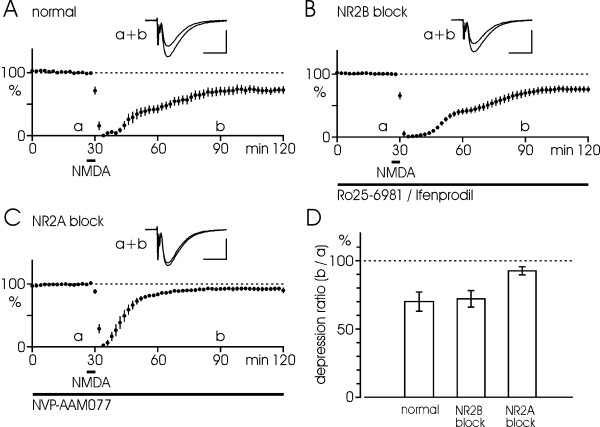
Roles of NR2B and NR2A subunits in NMDA-induced LTD. (A) NMDA application (30 μM, 4 min) under normal conditions causes initial extinction of EPSPs, followed by recovery and stabilization (n = 15). (B) NR2B inhibitors, Ro25-6981 (0.5 μM) or Ifenprodil (3 μM), do not affect NMDA-induced plasticity (n = 8+4 = 12). (C) In presence of NR2A inhibitor, NVP-AAM077 (0.4 μM), NMDA effects are different compared with control situation, with a shorter recovery phase and much less depression (n = 10). (D) Bar diagram reveals LTD at 60 min after NMDA application as percentage of the initial baseline under the different experimental conditions in A-C. Data are given as mean ± S.E.M. Black bars in A-C indicate the duration of drug treatment. Values are shown averaged for 2 min periods. Inserts illustrate EPSP-traces taken at the indicated time points (a, b). Calibrations: 0.5 mV, 10 ms.